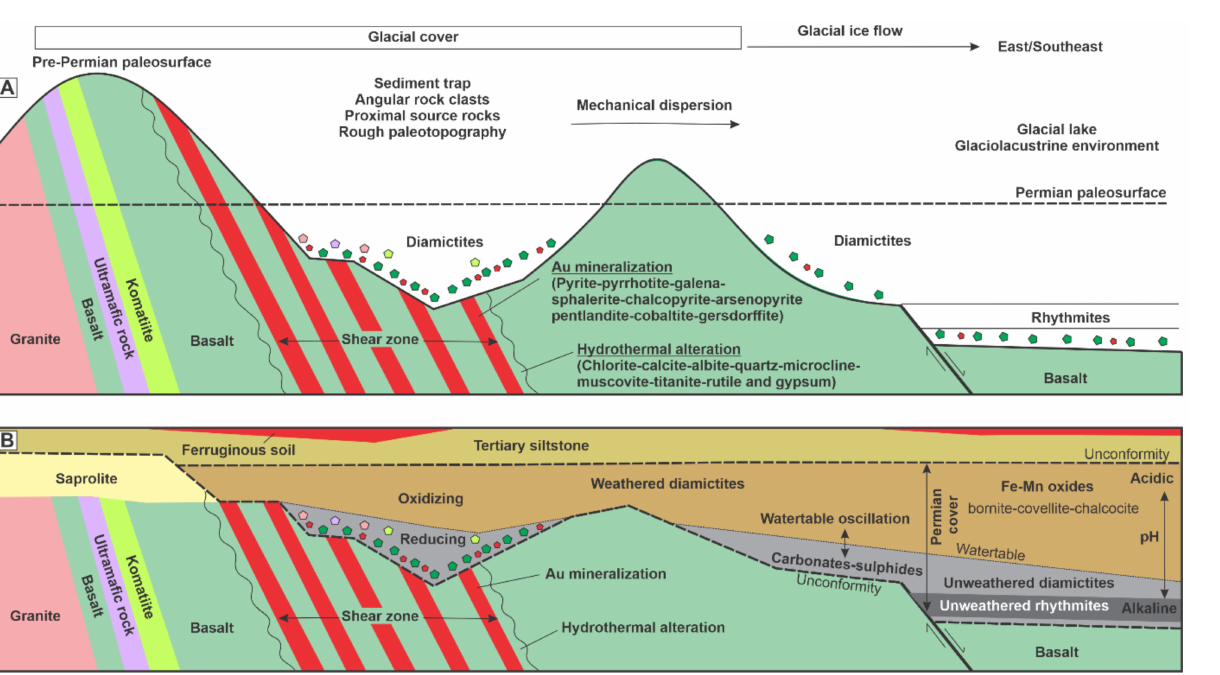
Figure 19. Conceptual model of ( A ) the pre-Permian paleolandsurface and ( B ) the Permian–Cenozoic landscape evolution at the Lancefield North prospect. It shows the pre-Permian irregular topography, denudation of paleohighs, and deposition in the nearby paleolows. Fresh detrital Fe, Cu, As, Zn, Pb, Co, and Ni sulfides are trapped in a paleolow that runs parallel to the strike of the hydrothermally altered, shear zone-hosted gold mineralization. Diagenetic sulfides and Fe–Mn oxides are formed during diagenesis and weathering of the Permian cover under alkaline and oxidizing pH conditions related to the oscillation of the underlying water